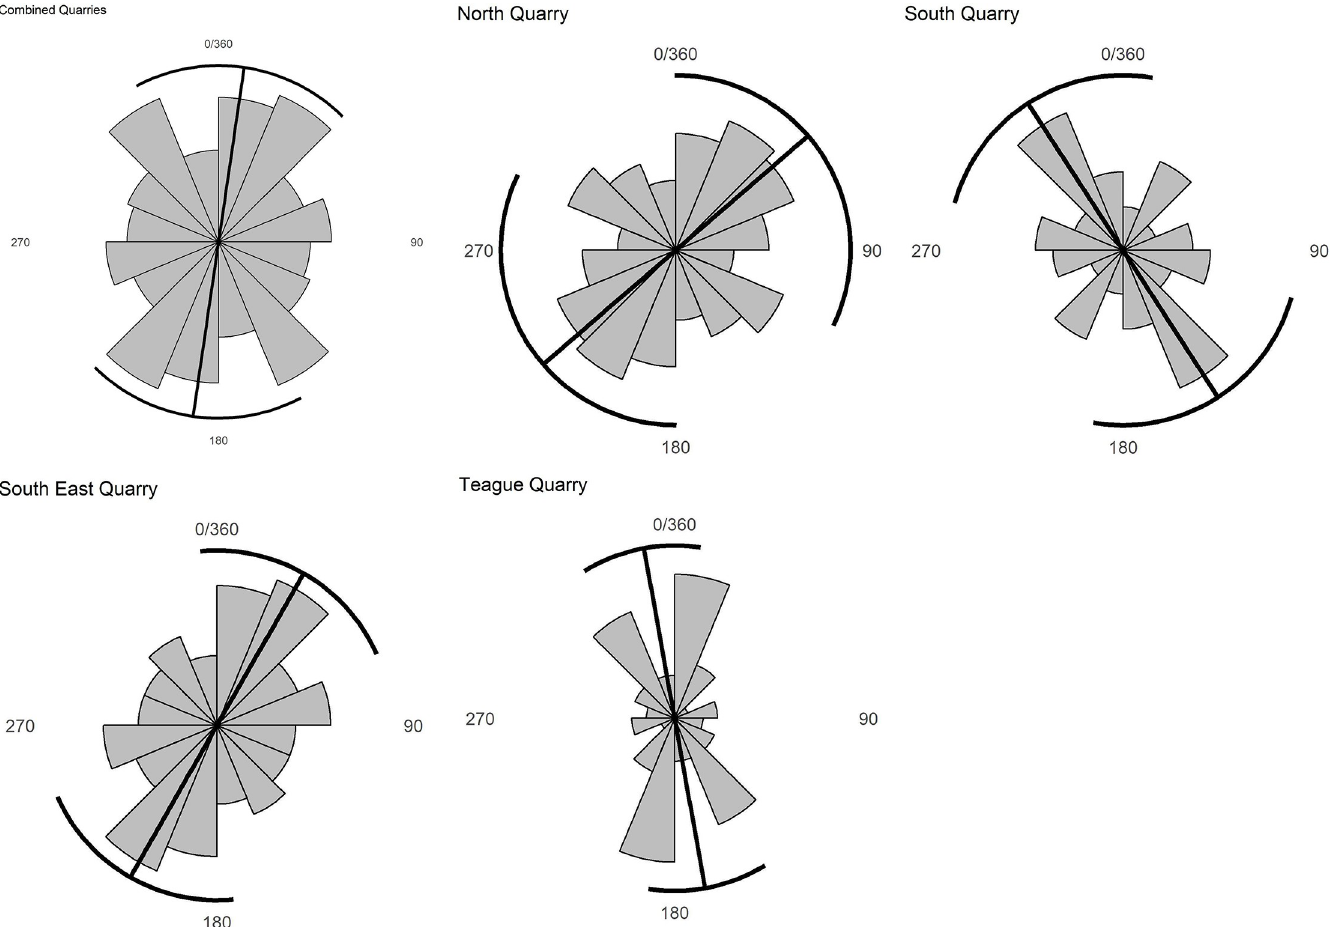
Fig 8. Long bone orientation in the main quarries. Outer lines are bootstrapped 95% confidence intervals.